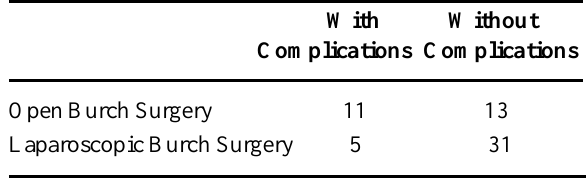
Table 7 – Presence of intercurrences until the 30th post- operative day ( c 2 = 6.36, p = 0.01).